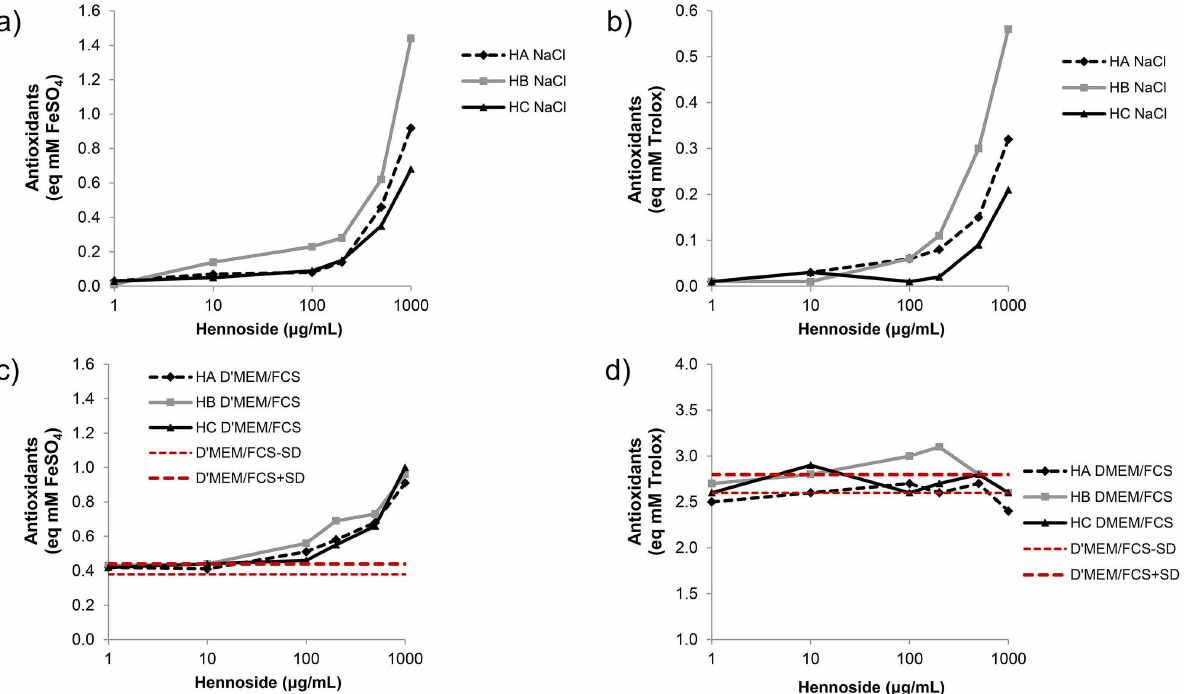
Figure 2. Antioxidant activity of hennosides in isotonic NaCl and Dulbecco’s Modified Eagle Medium supplemented with 10% fetal calf serum (D’MEM/FCS). Antioxidant activity measured by FRAP ( a , c ) and ABTS ( b , d ) assay. HA—hennoside A; HB—hennoside B; HC—hennoside C; NaCl—0.9% NaCl; D’MEM/FCS: D’MEM cell culture medium supplemented with 10%FCS; ( a , b ) Values represent the concentration of antioxidants diluted in 0.9% NaCl. ( c , d ) Values represent the concentration of antioxidants diluted in D’MEM + 10%FCS; Red lines indicate mean—1SD (D’MEM/FCS − SD) to mean + 1SD (D’MEM/FCS + SD) range of antioxidant concentration in